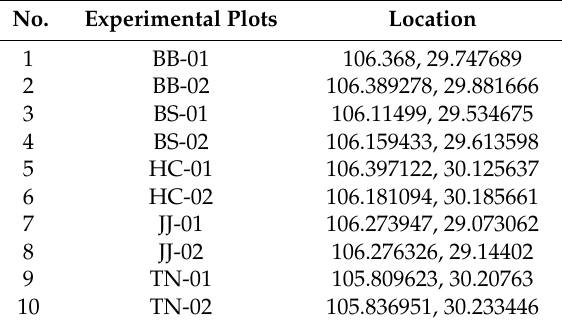
Table 1. The location of experimental